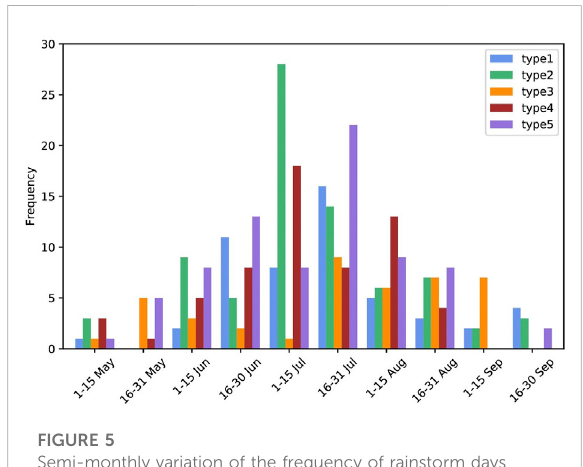
FIGURE 5 Semi-monthly variation of the frequency of rainstorm days associated with NECVs under fi ve types of synoptic circulation